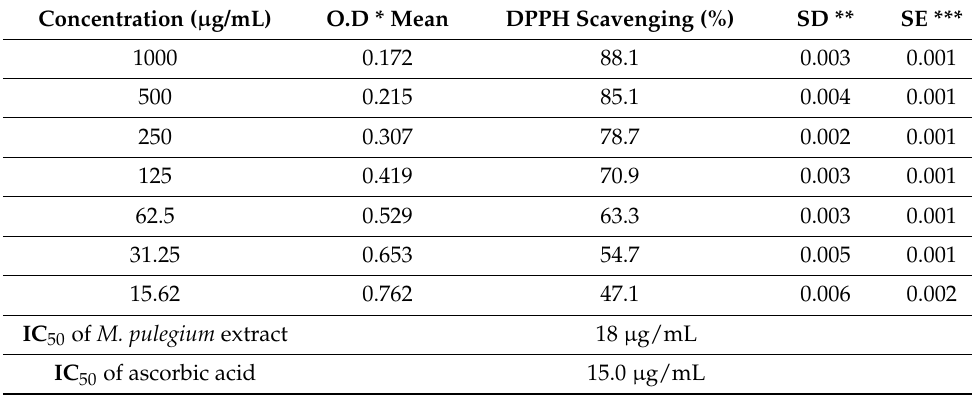
Table 4. Antioxidant activity of M. pulegium extract. Concentration ( µ g/mL) O.D *